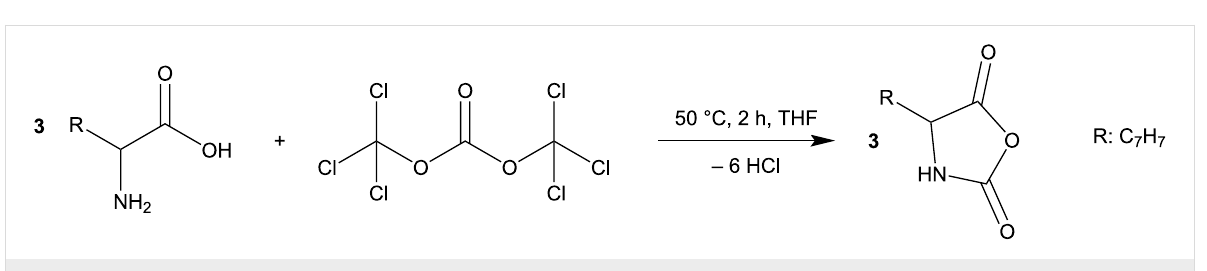
Figure 2: Synthesis of NCA-monomers from α -amino acids and